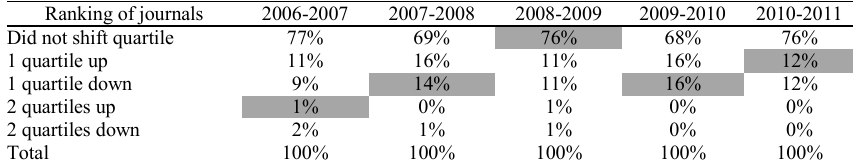
Table 1. Percentages of zoology journals in Sample 1 according to changes in quartile ranking of the IF.